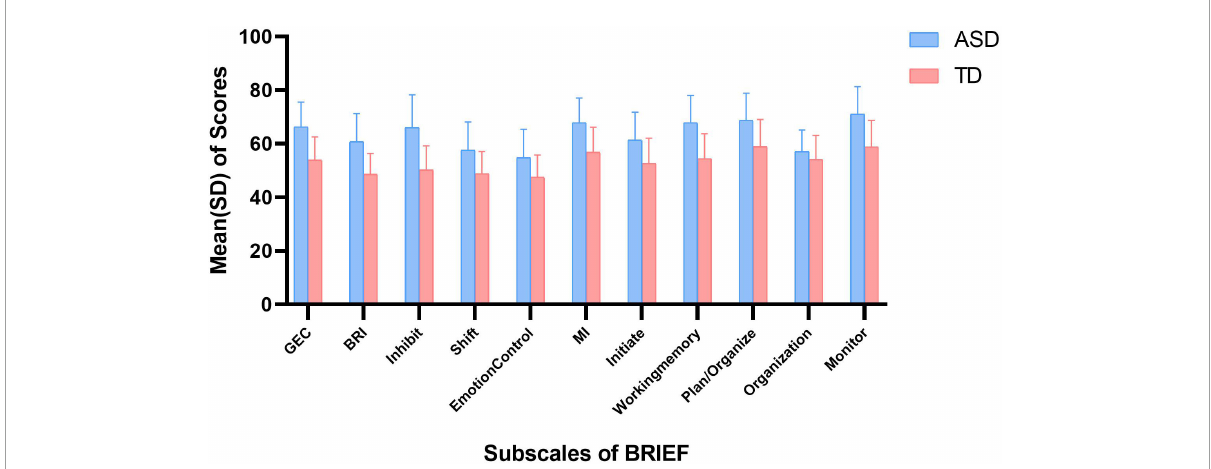
FIGURE2 Scores of BRIEF in ASD and TD children. ASD, autism spectrum disorder; TD, typically developing; SD, standard deviation; GEC, global executive component; BRI, behavioral regulation index; MI, metacognition